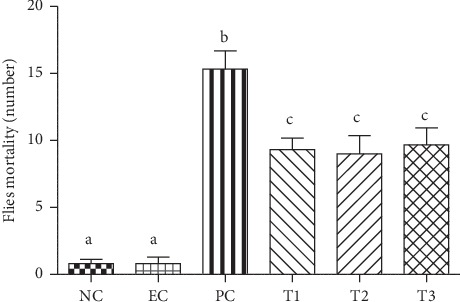
PQ poisoning control trial represented by mortality (number of dead individuals) per group. NC: Negative Control (1% sucrose); EC: Extract Control (10 mg/mL extract leaf); PC: Positive Control (3 mM PQ); and treatment: (T1 = 3 mM PQ + 1 mg/mL extract; T2 = 3 mM PQ + 5 mg/mL extract; T3 = 3 mM PQ + 10 mg/mL extract). Different letters represent statistical differences according to Tukey's test (p < 0.0001).